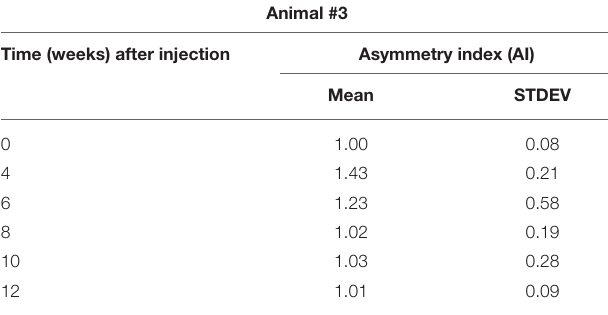
TABLE 2 | Asymmetry Index dynamics over time after